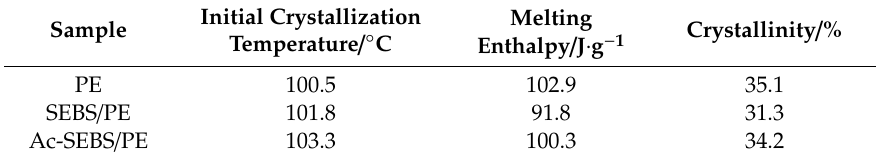
Figure 5. Infrared spectrum pre-and post-extraction of 1-(4-vinyloxy)phenylethenone (VPE/PE) and Ac-SEBS/PE. ( a ) VPE/PE, ( b ) Ac-SEBS/PE. 3.6. DC Breakdown Strength of Ac-SEBS/PE